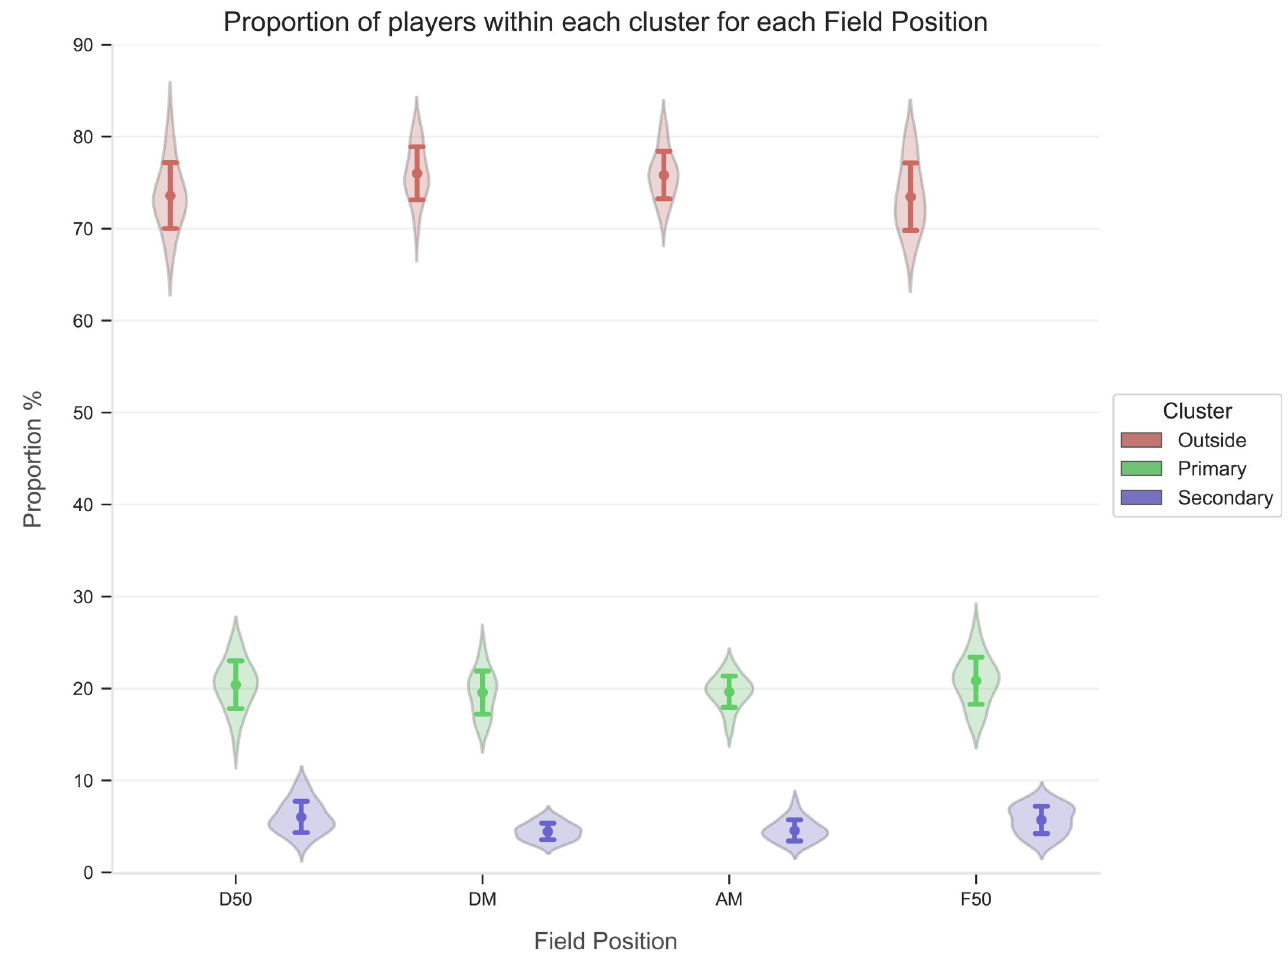
Fig 2. Proportion of players (mean ± standard deviation) in each cluster compared across field position. D50, Defensive 50; DM, Defensive Midfield; AM, Attacking Midfield; F50, Forward 50.